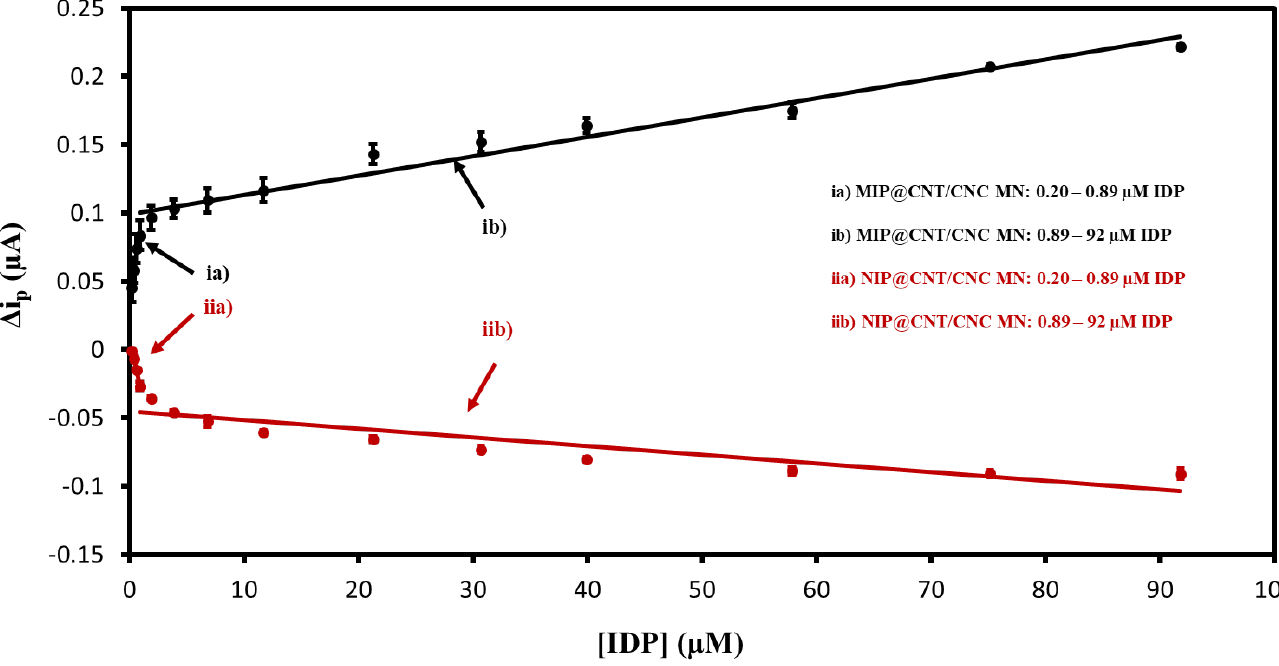
Figure 7. Peak DPV current ( ∆ i p ) vs. imidacloprid (IDP) concentration calibration curves for (ia)